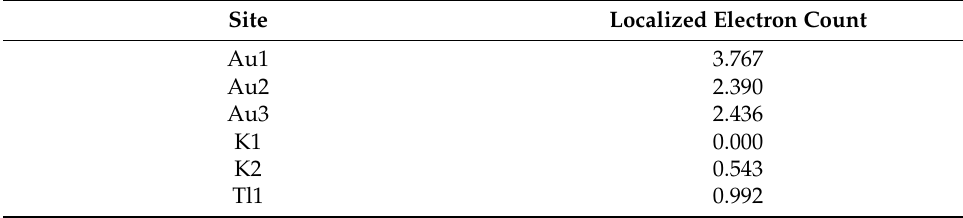
Table 2. Calibrated localized electron counts for K 3 Au 5